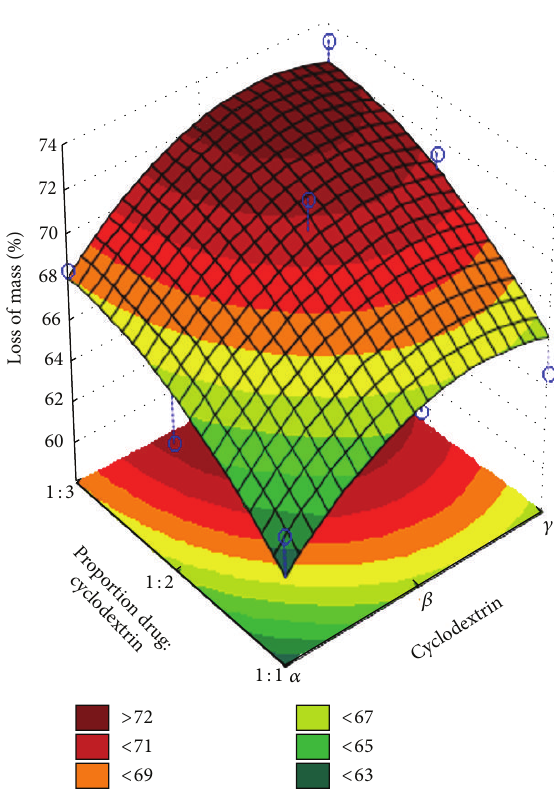
Figure 4: The resulting surface-response graph of the statistical analysis of the impact of the drug-CD ratio and the type of CD on the mass loss in the thermogravimetric assay.